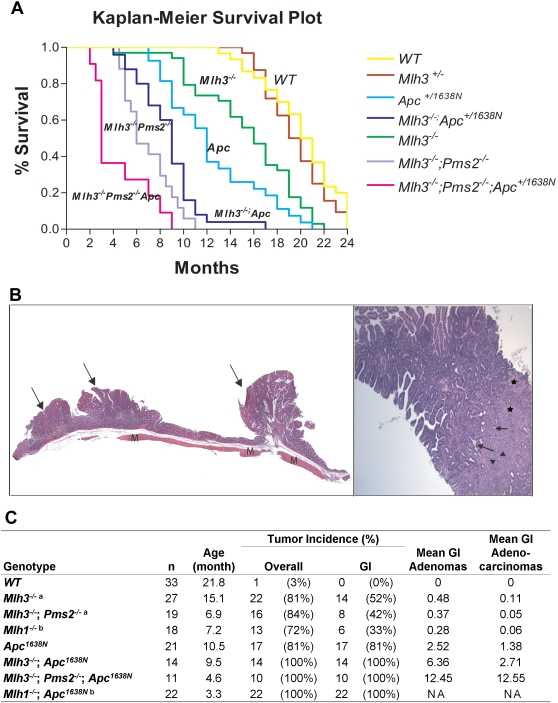
Decreased survival and increased tumor multiplicity and progression in MPA mice.(A) Kaplan-Meier survival analysis of mice deficient in Apc and DNA Mismatch Repair genes. (B, left) Three small intestinal adenomatous polyps from MPA mouse duodena are seen in cross-section (arrows, left panel). (B, right panel) Example of a jejeunal adenocarcinoma from an MPA mouse, showing atypical glands (arrows) invading deeply into a desmoplastic stroma (asterisks) containing a mixed chronic inflammatory reaction (arrowheads). (C) Tumor incidence and multiplicity. a Data from Chen et al[13]. b Data from Edelmann et al
[35], for comparison. NA, data not available.